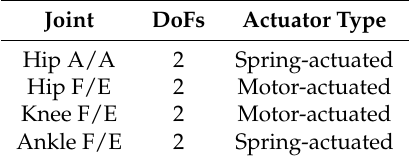
Figure 3. The Shenzhen Institutes of Advanced Technology (SIAT) lower-limb exoskeleton robot. The left is the mechanical structure diagram, and the right shows the exoskeleton worn by the human. Table 1. The joint actuator types. A/A, abduction/adduction; F/E,